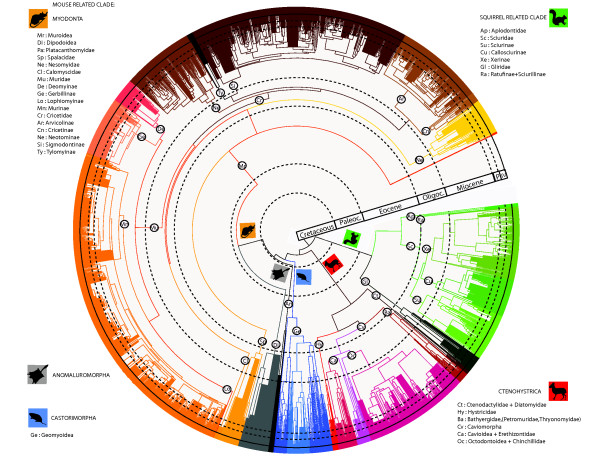
Rodent species-level evolutionary dated tree. The species-level chronogram is based on the ML topologies from 8 supermatrix trees. Stratigraphic scale : P : Paleocene, E : Eocene, O : Oligocene, M : Miocene, P : Pliocene, Pl : Pleistocene. Bootstrap and divergence time estimates for all nodes are detailed in Supplementary Data.